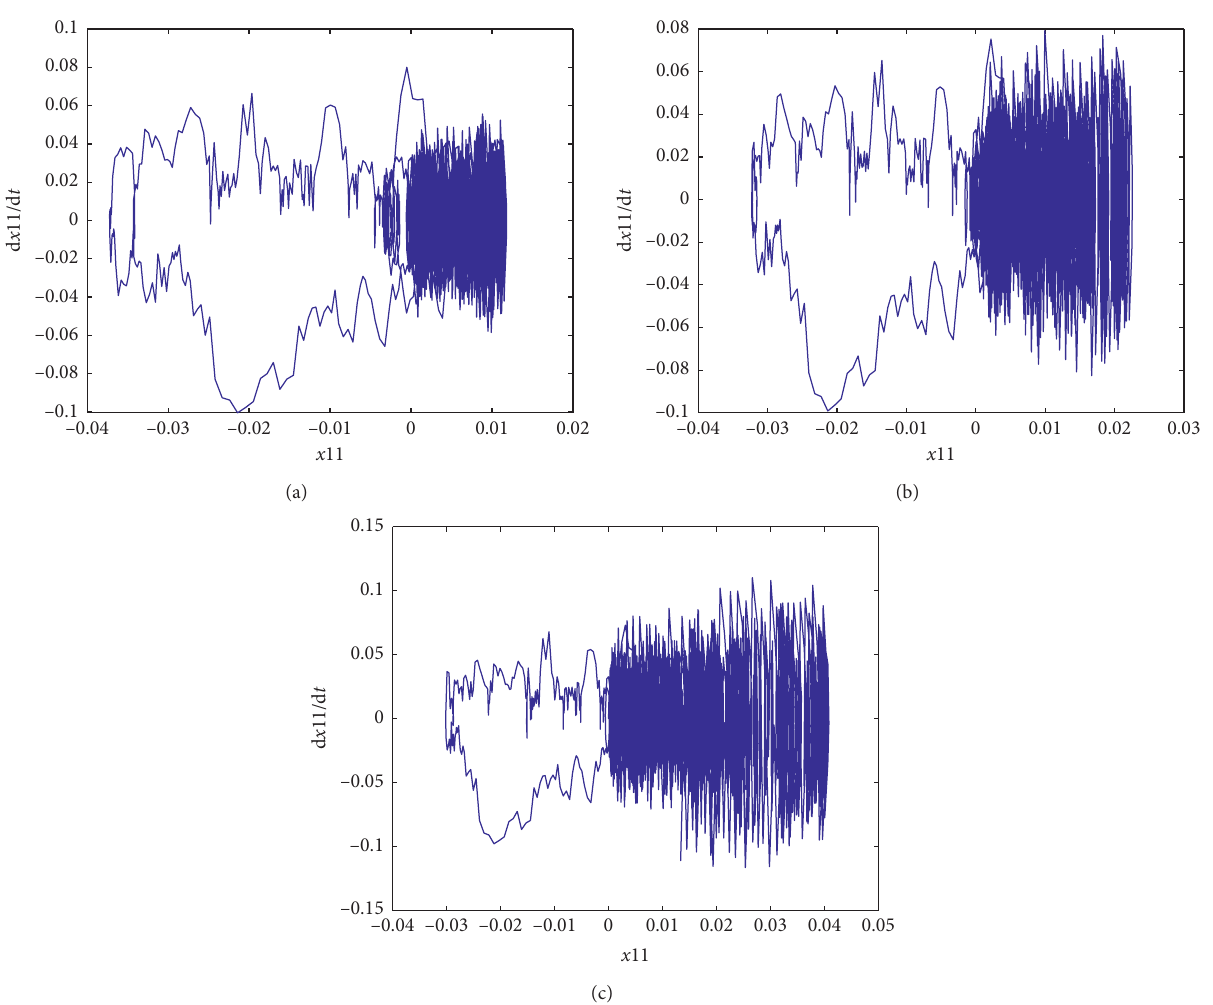
Figure 19: Related phase portrait to Figure 18. (a) α � 0 . 05. (b) α � 0 . 1. (c) α � 0 .